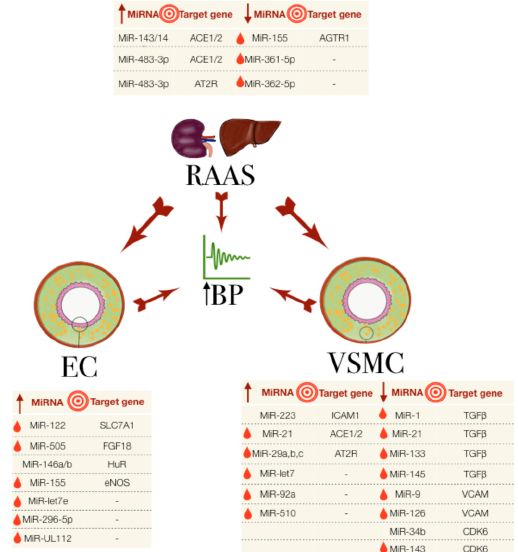
Figure 1. The miRNAs involved in essential hypertension, their association with the RAAS, EC and VSMC and their known target genes. The big central arrows indicate a system/cell type’s influence on another and on the increase in blood pressure (BP). Small arrows in the tables indicate the upregulated (up arrow) or downregulated (down arrow) miRNA expression. Red droplets represent the biomarker potential from detectability in blood samples. EC: endothelial cells; RAAS: renin-angiotensin aldosterone system; VSMC: vascular smooth muscle cells.